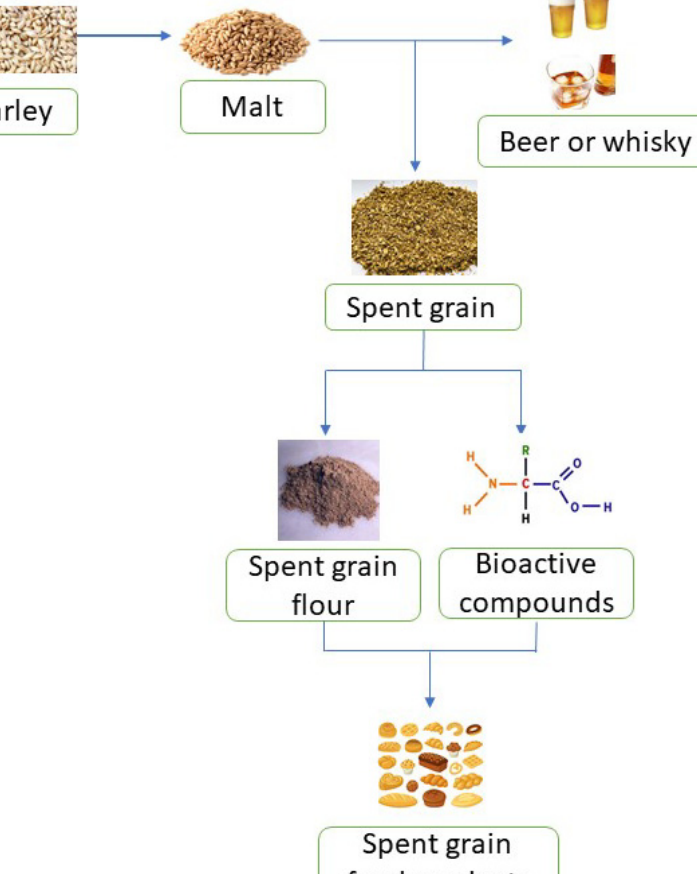
Figure 1. Synthetic process of generating and using spent grain to produce food products.